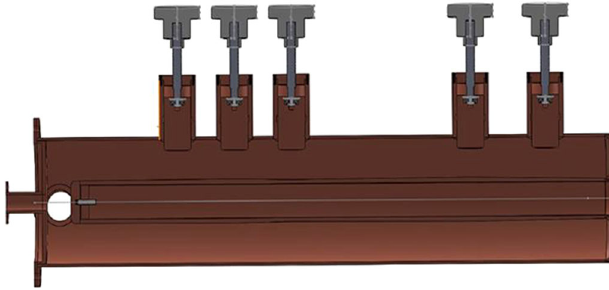
FIG. 11. A prototype cavity with five manual stub tuners for tuning five harmonic frequencies.